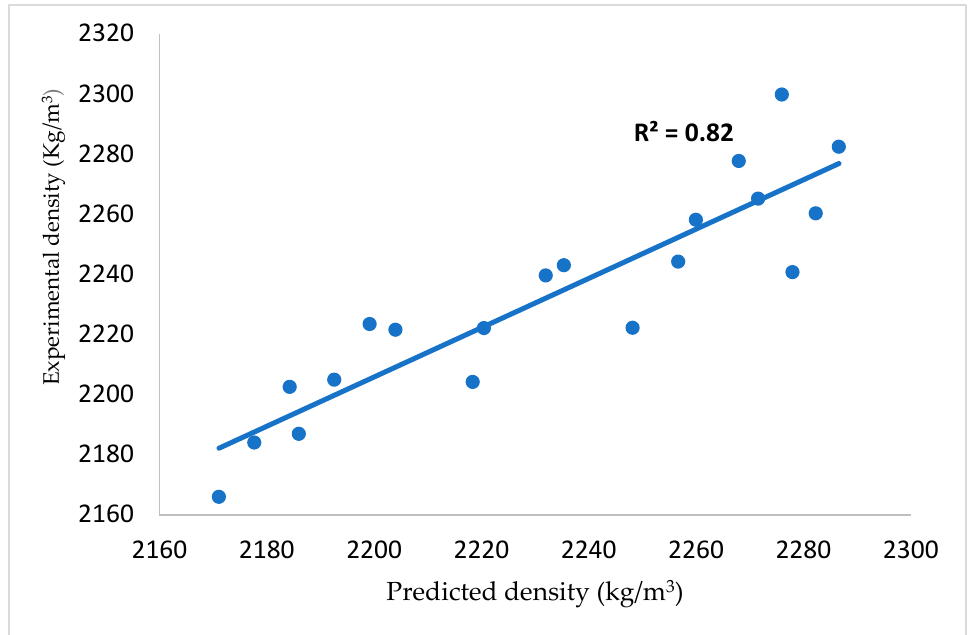
Figure 7. Experimental and predicted density value of glass blended cement mortar.